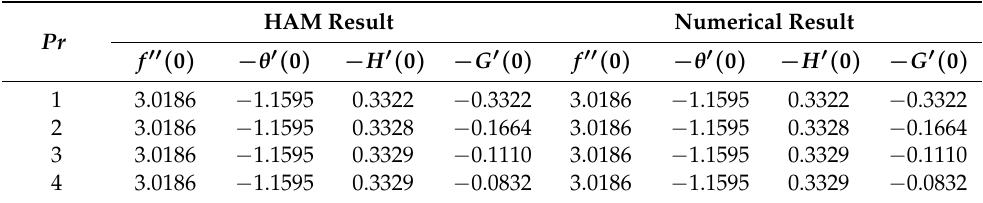
Table 7. Computational for f (cid:48)(cid:48) ( 0 ) , − θ (cid:48) ( 0 ) , − H (cid:48) ( 0 ) and − G (cid:48) ( 0 ) with S = − 0.5, Ha = R = Sc = K 1 = K 2 = 0.5, δ = L = 2, Q = 4 and differing values of P r .